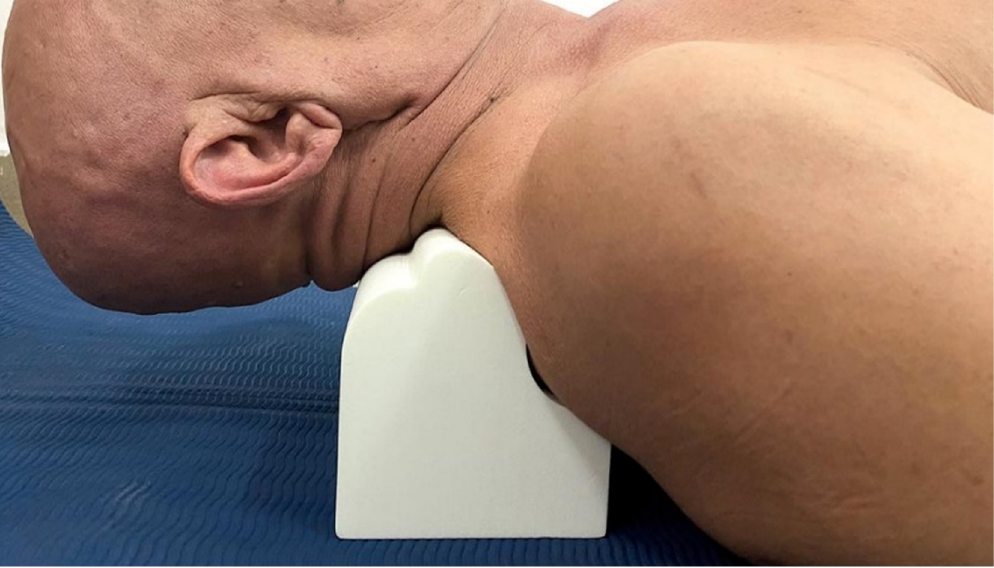
Figure 1. Cervical Denneroll™ traction.